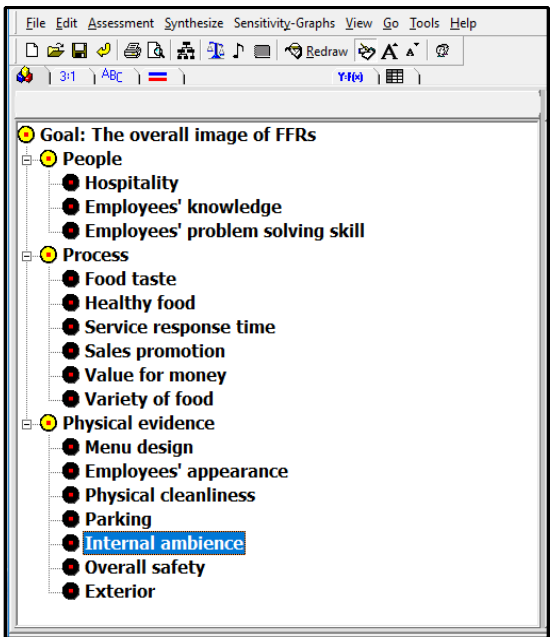
Information 2022 , 13 , x FOR PEER REVIEW Figure 3. A screenshot of FFR image evaluation hierarchical model from Expert Choice.